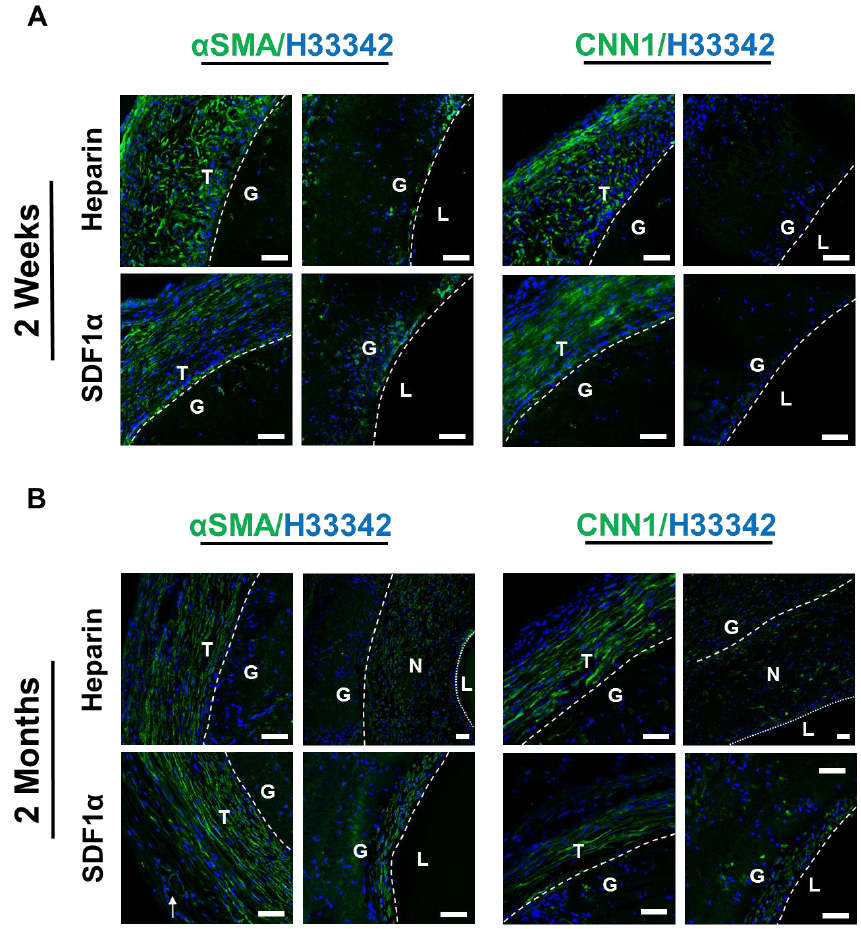
Figure 8. Identification and characterization of SMCs. Immunostaining for α SMA ( green ) and CNN1 ( green ) of heparinized and SDF-1 α immobilized grafts at ( A ) 2 weeks and ( B ) 2 months after implantation. Nuclei were stained with Hoechst 33342 ( blue ). Dashed lines are used to distinguish the boundaries between L (lumen), N (neointima), G (graft), and T (surrounding tissues). Arrow indicates neovascularization on the outer surface of the grafts. Scale bar = 50 µ